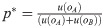
Value-distorted subjective probability π(p) given by expression (20): (Left) fixed u(oA) = u(oB) = 30, D is varied.As D grows, π(p)→p; (right) fixed D = 20 and u(oB) = 30, u(oA) is varied. As u(oA) grows, the inflection point p*=u(oA)(u(oA)+u(oB)) shifts toward the right while the curve shifts upward. Varying u(oB) gives symmetrical behaviors.